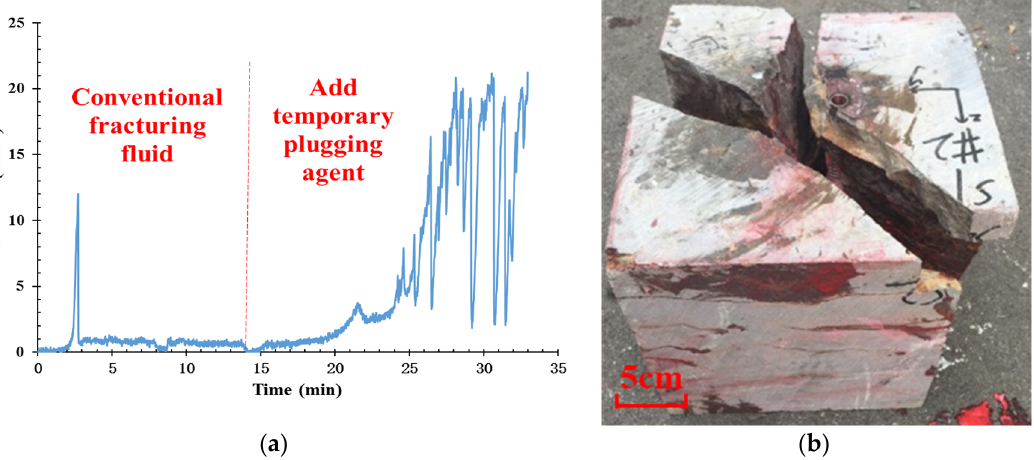
Figure 3. Pressure curve and fracture geometry of diversion experiment inside the fracture. ( a ) Pres- sure curve; ( b ) Fracture